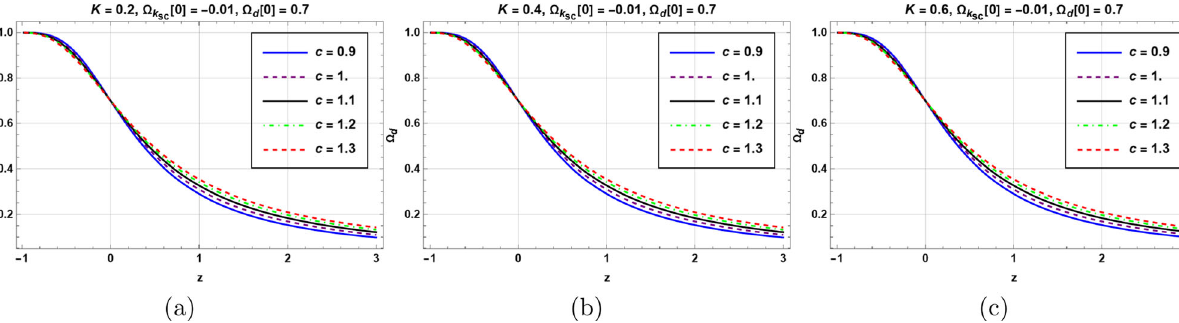
Fig. 2 The variation in the KHDE density parameter (cid:2) d with redshift z for the open universe, in units when M 2 p = 1 , H 0 = 67 . 9. In order to be consistent with data, we now imposed (cid:2) d ( x = − ln ( 1 + z ) = 0 ) = (cid:2) d [ 0 ] = 0 .